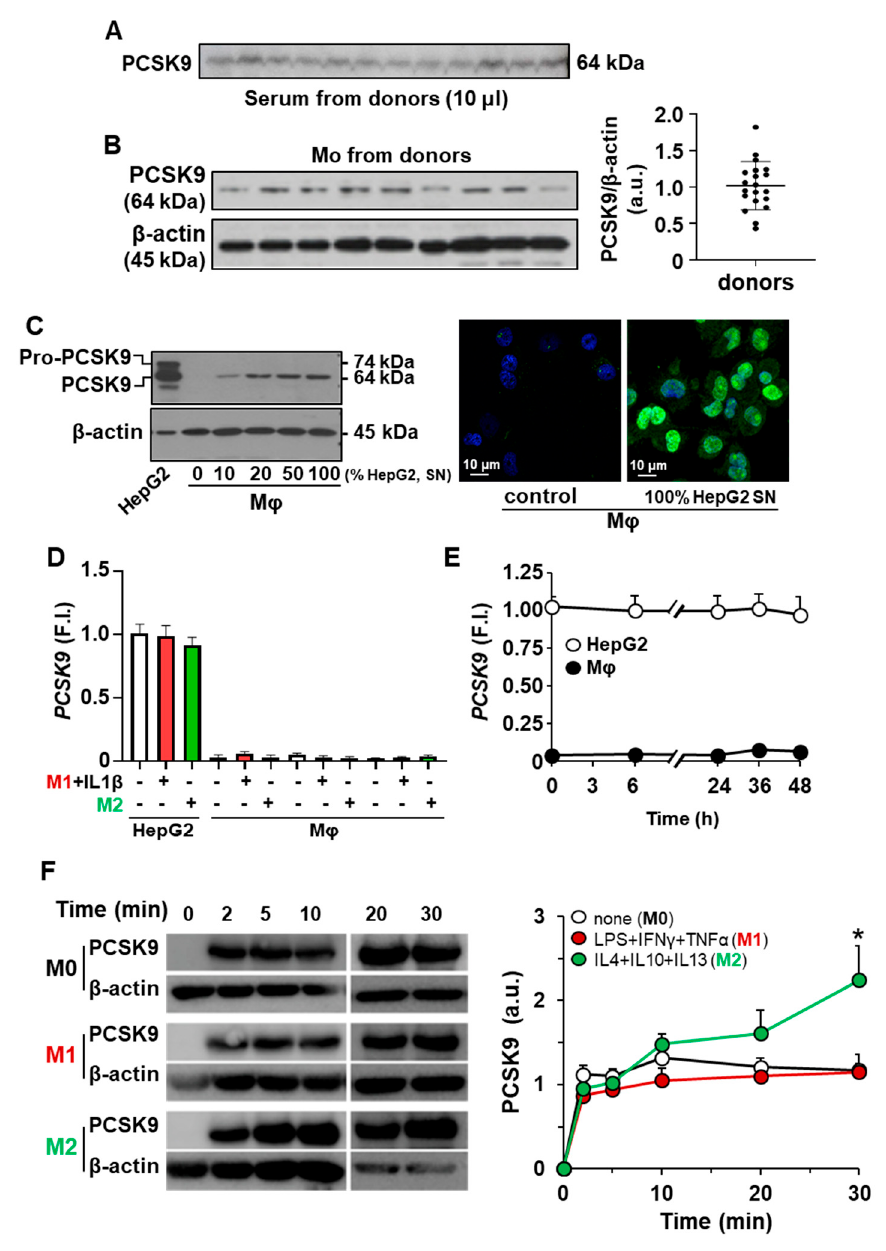
Figure 1. Incorporation of PCSK9 into human monocytes (Mo) and human macrophages (hM φ ). ( A ) Quantification of circulating PCSK9 in human serum from healthy donors after overnight fasting. Identical amounts of serum were analyzed by Western blot. ( B ) Determination of PCSK9 in circu- lating Mo from healthy donors. ( C ) Incorporation of PCSK9 from the culture medium of HepG2 cells (SN, 48 h in culture) in hM φ differentiated from circulating Mo ( left panel ). Immunofluores- cence of PCSK9 in hM φ (anti-PCSK9 antibody in green and DAPI in blue) treated for 30 min with a fresh medium or a conditioned medium from HepG2 cell cultures ( right panel ). ( D ) PCSK9 mRNA levels from HepG2 and human macrophages were treated for 18 h with the indicated stimuli. ( E ) Time-course of PCSK9 mRNA expression after incubation of hM φ with exogenous PCSK9. Values refer to HepG2 control condition. ( F ) Time-course of PCSK9 incorporation in hM φ polarized to M1- like or M2-like profiles. Resting (M0), M1, and M2 hM φ were treated with 0.5 µg/mL of recombinant human PCSK9, and the incorporation was determined by Western blot. Results show representative blots from 18 different donors ( A , B ), from 6 different donors and a representative image of PCSK9 incorporation ( C – E ), or 4 donors ( F ). * p < 0.05 vs. the corresponding M0 condition ( F ). F.I., fold induction ( D , E ).